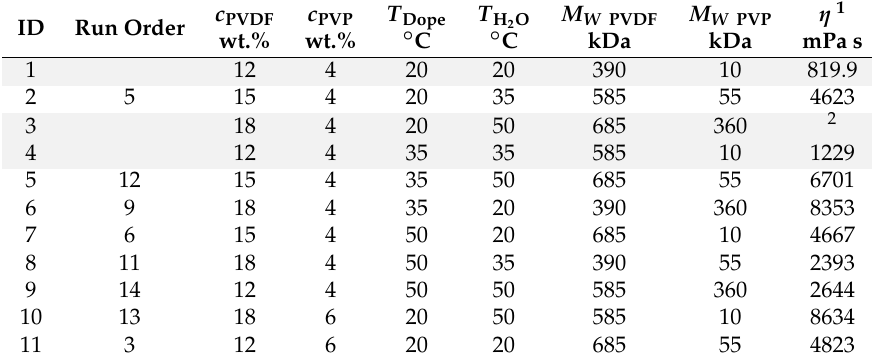
Table 1. Screening of dope solutions generated via Design of Experiments (DoE) and measured dyn. viscosity. Grey rows excluded from spinning experiments due to low